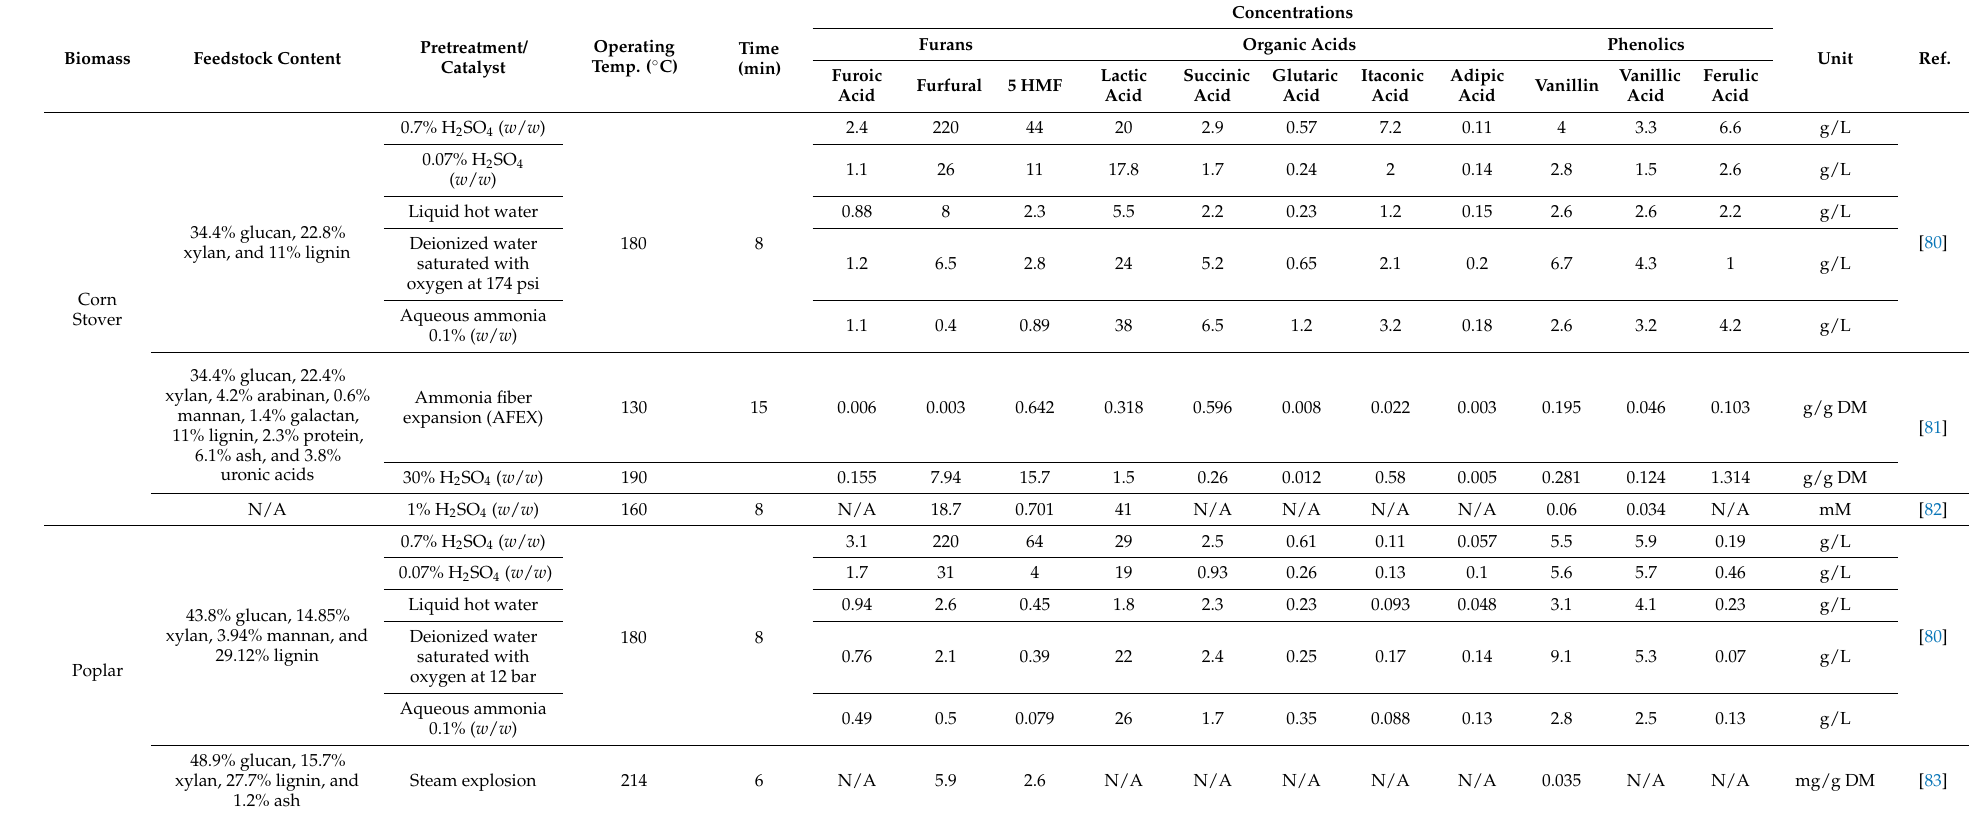
Table 4. Pretreatment conditions and concentrations of selected furans, organic acids, and phenolics.